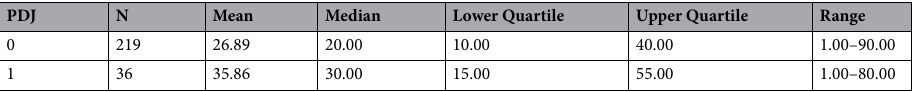
Table 4. Analysis variable: stromal TILS. PDJ positivity was associated with higher stromal tils counts (Wilcoxon Rank Sum 2-sided p-value =